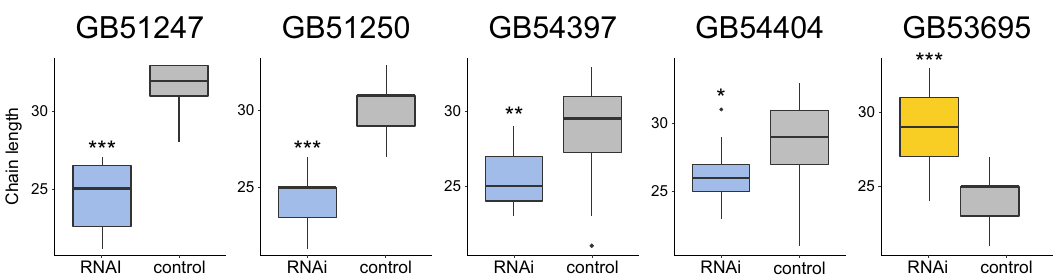
Fig. 7 Effects on chain lengths of cuticular hydrocarbons (CHCs) of RNAi-mediated knockdown of four fatty acid elongases and of one fatty acid amide hydrolase (FAAH) in worker honey bees ( Apis mellifera ) 2 – 5 days after dsRNA treatment. Box plots of the chain lengths of CHCs positively associated in a powered partial least squares discriminant analysis along the fi rst principal component with bees treated with dsRNA targeting fatty acid elongases (in bue: GB51247 , GB51250 , GB54397 , GB54404 ) or fatty acid amide hydrolase (FAAH, in yellow: GB53695 ) and with control bees (in grey, injected with dsRNA targeting GFP). Asterisks indicate statistical signi fi cance of abundance differences between the two treatment groups after Holm-Bonferroni correction for multiple ( N = 5) testing (Welch ’ s t-test: p ≤ 0.05 [*], p ≤ 0.01 [**], p ≤ 0.001 [***]).